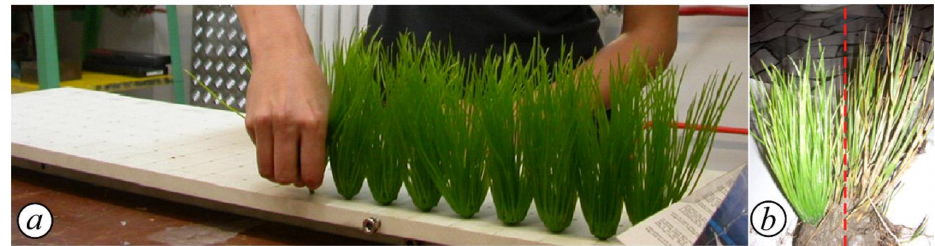
Figure 2. Vegetation used in the experiments. ( a ) Plant housing into a drilled PVC panel; ( b ) comparison between silicone plant (left) and Spartina maritima harvested in the Venice Lagoon (right).